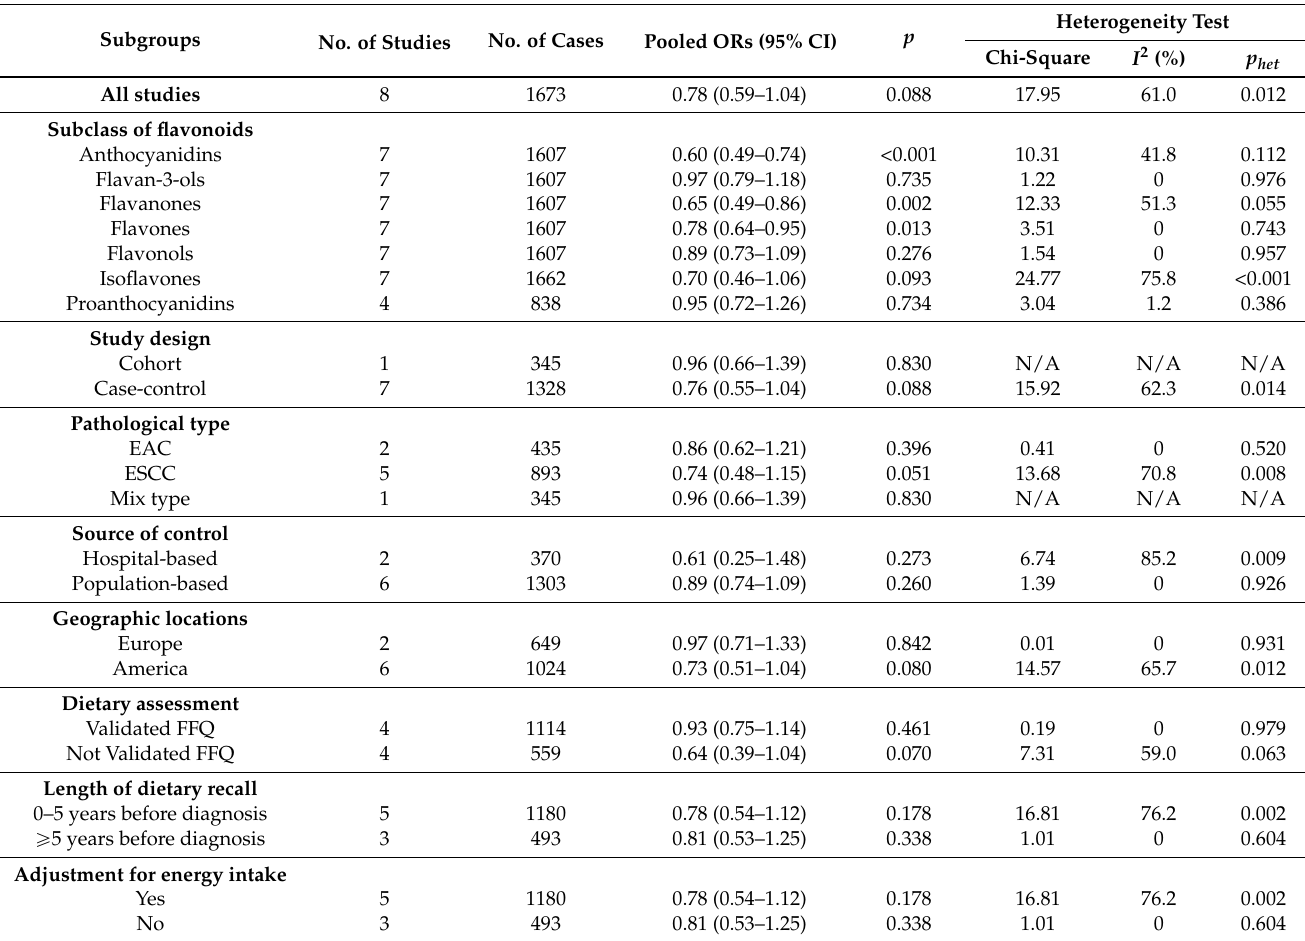
Table 2. Meta-analysis of risk estimates of flavonoids intake (highest versus lowest) and esophageal cancer risk.